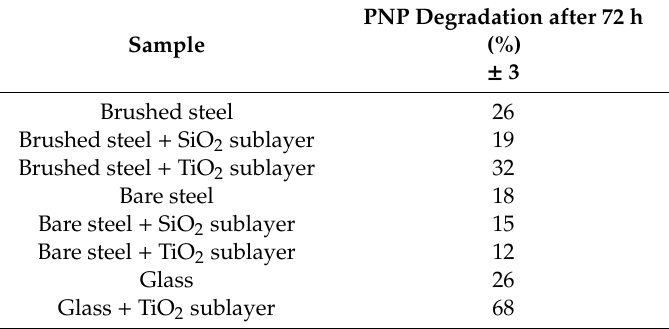
Table 3. PNP degradation (%) under UV-A light ( λ = 365 nm) after 72 h for the TiO 2 / Fe0.5 colloid deposited on various surfaces.